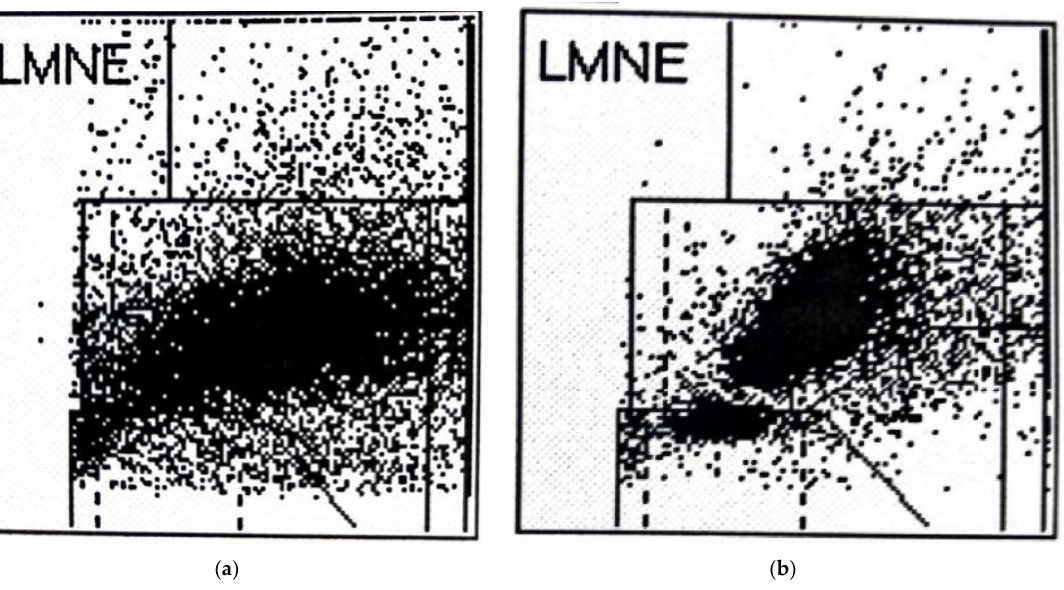
Figure 5. ( a ): LMNE matrix of a type VI (combined type II of hematoma and infection) 3 weeks after implantation of a hip arthroplasty with a cluster in the area of the neutrophil leukocytes and increases in the other areas of the white blood cells in a 57-year-old male patient with an early periprosthetic joint infection. The measured cell count was 62,750 cells/µL with 83.8% PMN and a CRP of 255.1 mg/L. ( b ): LMNE matrix of a type VI (combined type II of hematoma and infection) 3 weeks after implantation of a hip arthroplasty with a cluster in the area of the neutrophil leukocytes and increases in the other areas of the white blood cells in a 53-year-old male patient with an early periprosthetic joint infection. The measured cell count was 32,750 cells/µL with 80.4% PMN and the CRP was 66.9 mg/L.